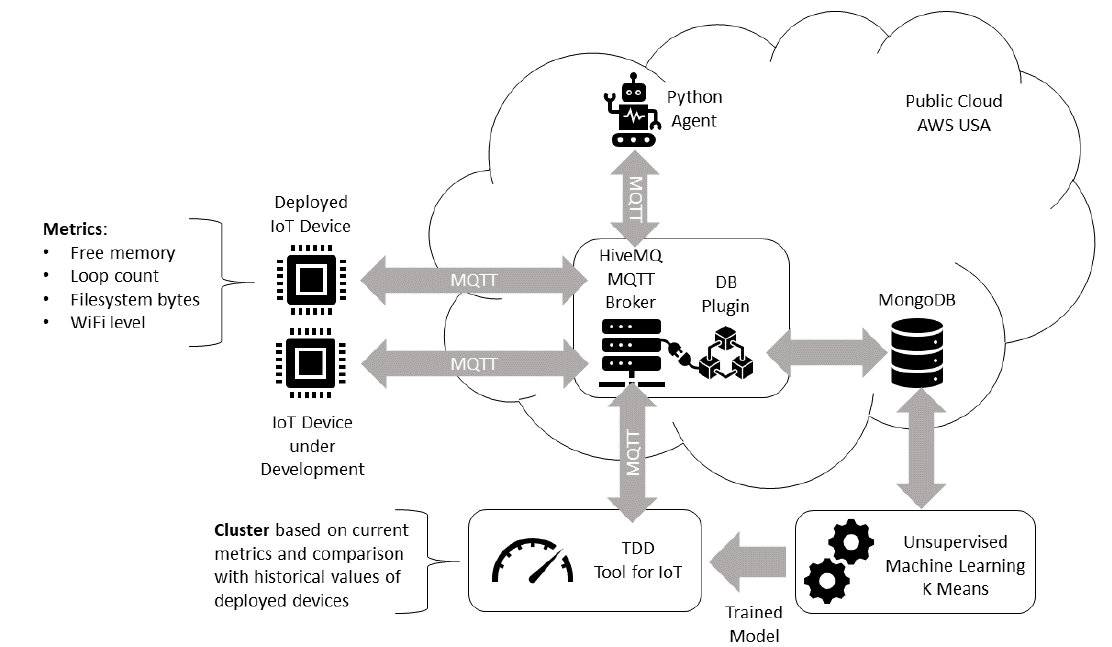
Figure 12. Smart Home study case architecture.